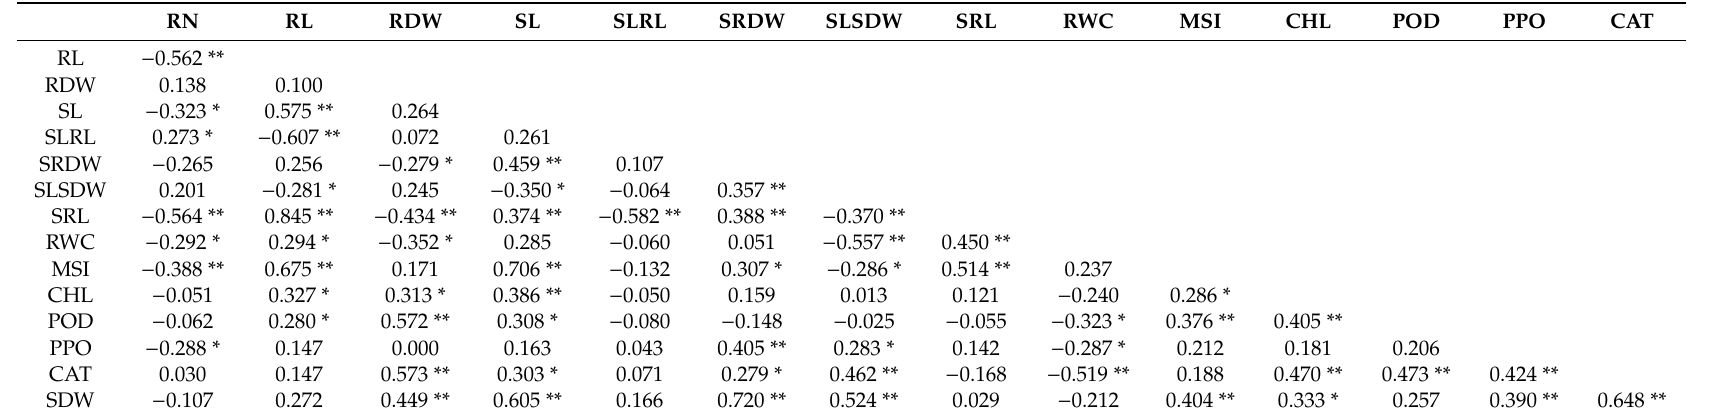
Table 6. Simple correlation coe ffi cients among 15 measured traits of 16 wheat genotypes at three salinity levels ( n =